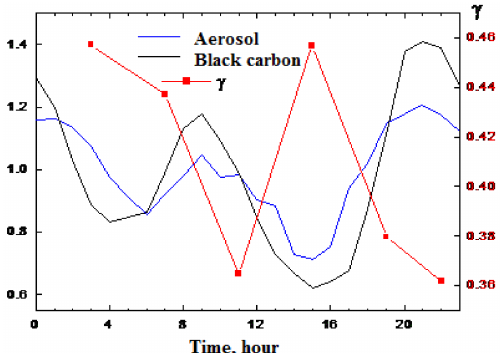
Figure 8. Normalized daily average variations in the mass con- centrations of dry base of submicron aerosol and black carbon, smoothed using three-point moving average, and daily average vari- ations in the condensation activity parameter during 1–9 April 2013.